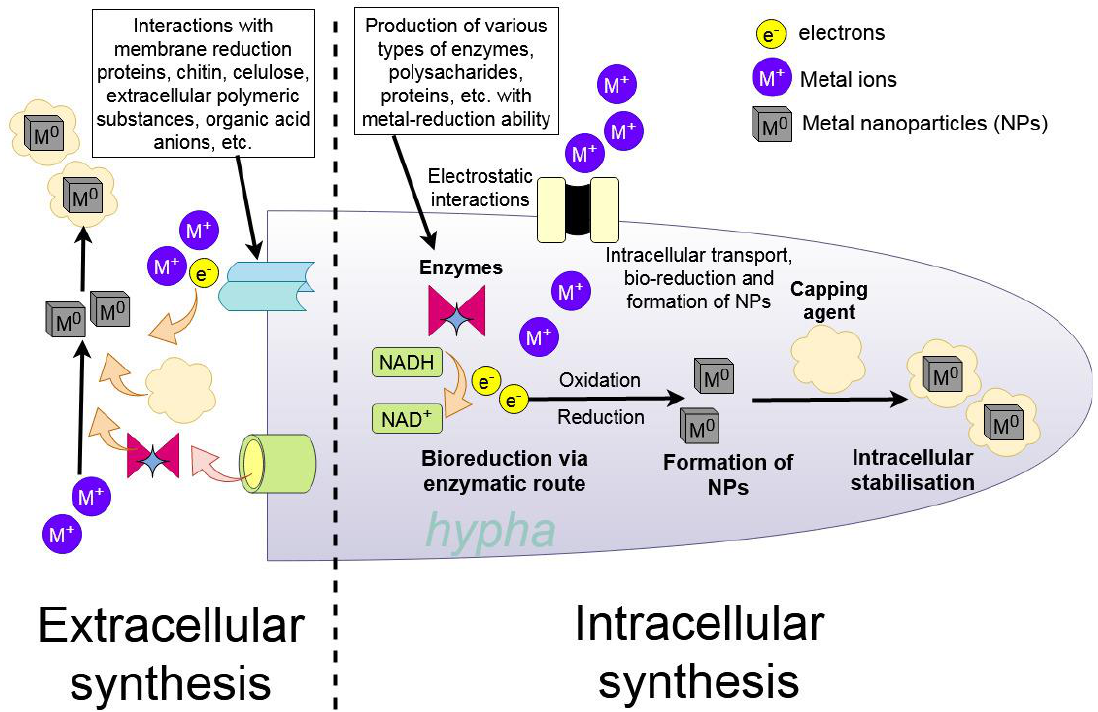
Figure 6. Mycosynthesis — the creation of metal NPs via the interaction with fungus and its metabolites.